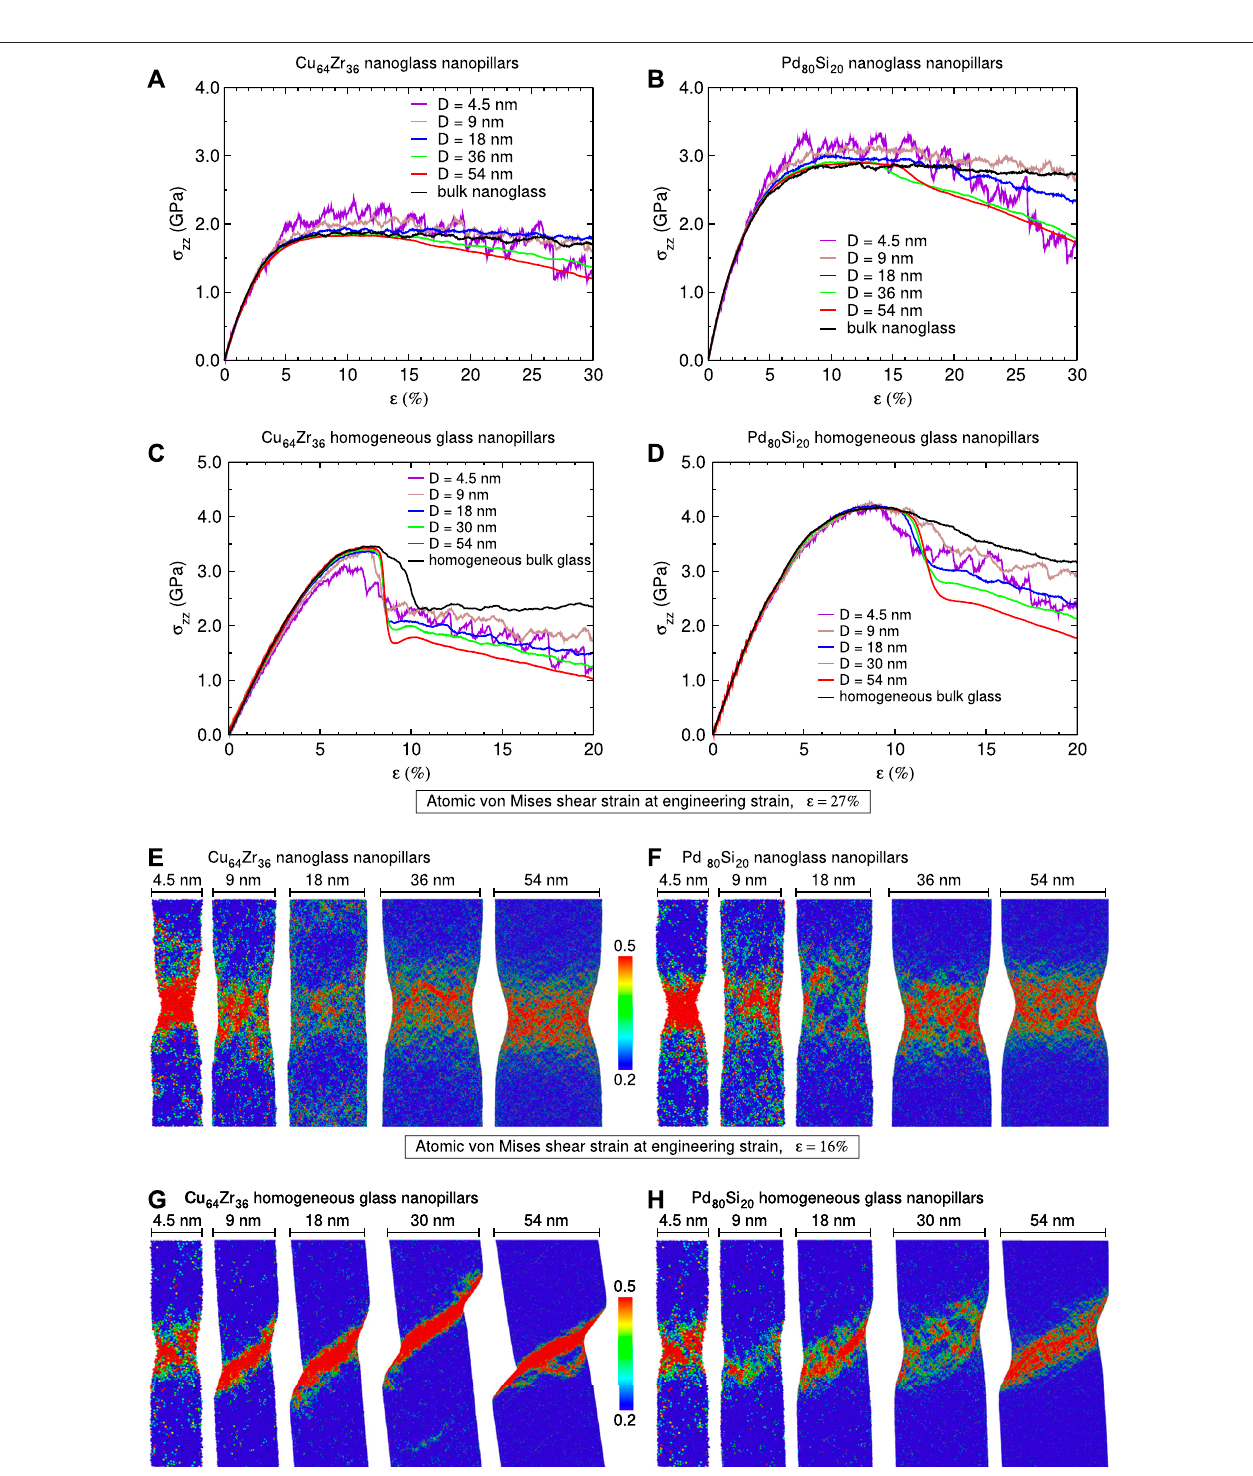
FIGURE 1 | Tensile test of Cu 64 Zr 36 and Pd 80 Si 20 nanoglass (NG) and homogeneous glass (HG) nanopillars with an average grain size of d (cid:2) 7 nm and diameters rangingfromD (cid:2) 4.5 – 54 nm. (A,B) Engineeringstress – straincurves forNGnanopillars. (C,D) Engineeringstress – straincurvesforHGnanopillars. (E,F) LocalvonMises shear strain at 27% total strain, showing strain localization in the NG nanopillars. (G,H) Local von Mises shear strain at 16% total strain, showing strain localization in the HG nanopillars. Engineering stress – strain curves for HG and NG bulk samples are added for reference; those for Cu 64 Zr 36 bulk samples are taken from reference (Adjaoud and Albe,